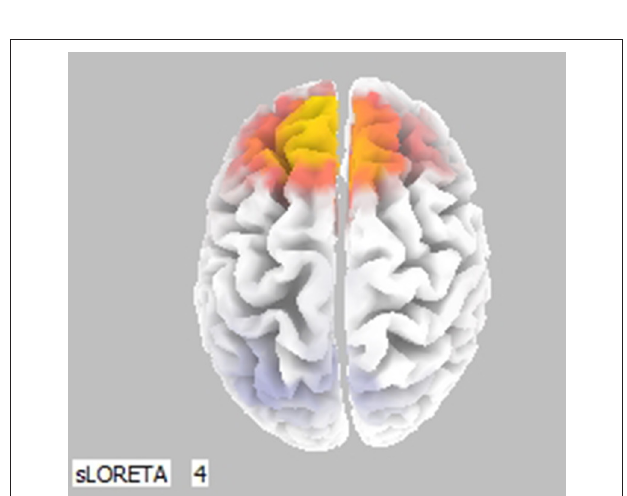
FIGURE 4 | Statistically significant cerebral activity was estimated by LORETA software in the Upper Alpha Band comparing two pieces of information presented for scenario (0, SN + SP) with scenario (SN, SP). Orange areas suggest a significant increase in cortical activity for the scenario (0, SN + SP) with respect to the other